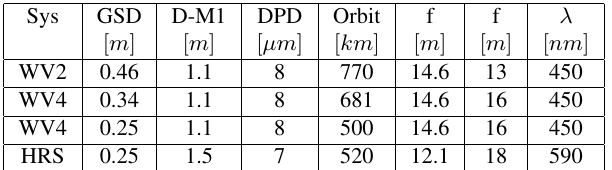
Table 1: Example 1 of a table 4 OPTICS, DETECTOR AND